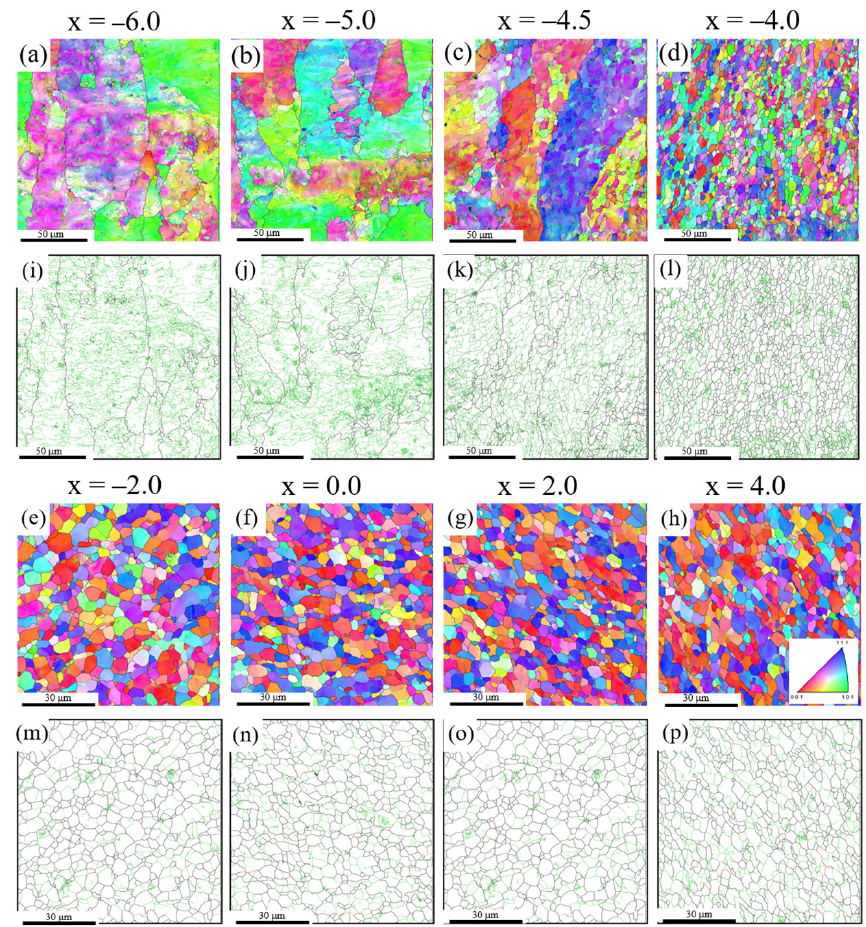
Figure 6. ( a – h ) IPF and ( i – p ) grain boundary maps for the pure Al joint at 0.67 T m in the range of − 6.0 < x < 4.0.